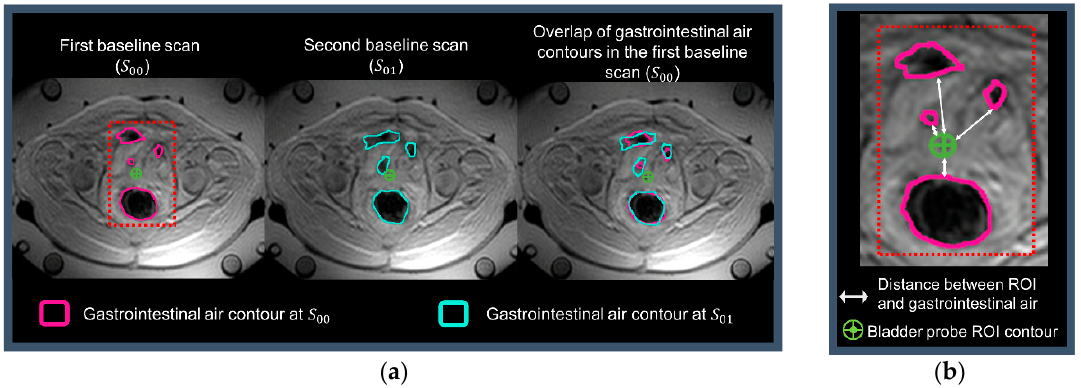
Figure 3. The axial anatomic images and a zoomed region from MR thermometry reference scans are shown: ( a ) presents the gastrointestinal air contours in the two first baseline scans and the overlap of these contours in the first baseline scan; ( b ) shows the distances between the probe and gastrointestinal air contour. This representative treatment session presented: Jaccard coefficient = 0.67; minimum distance = 0.2 cm; fat volume = 8782.7 mL; and gastrointestinal air volume = 548.5 mL.